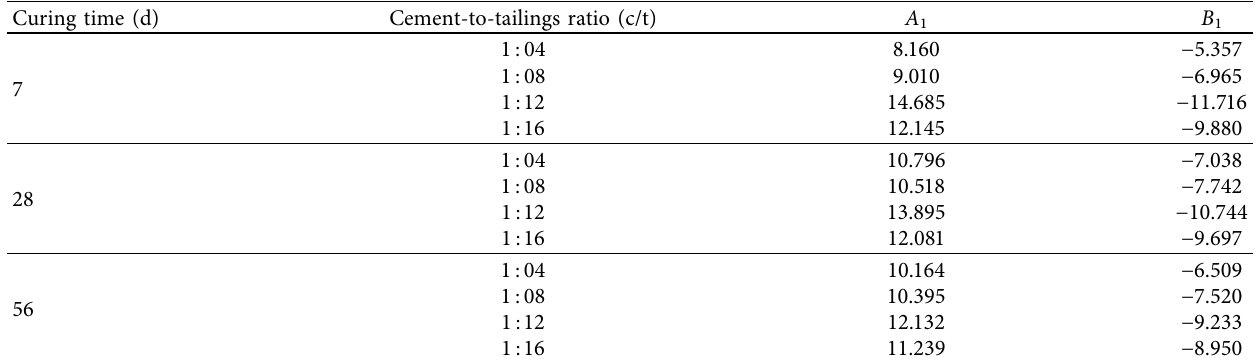
Table 15: Equation parameters results under various